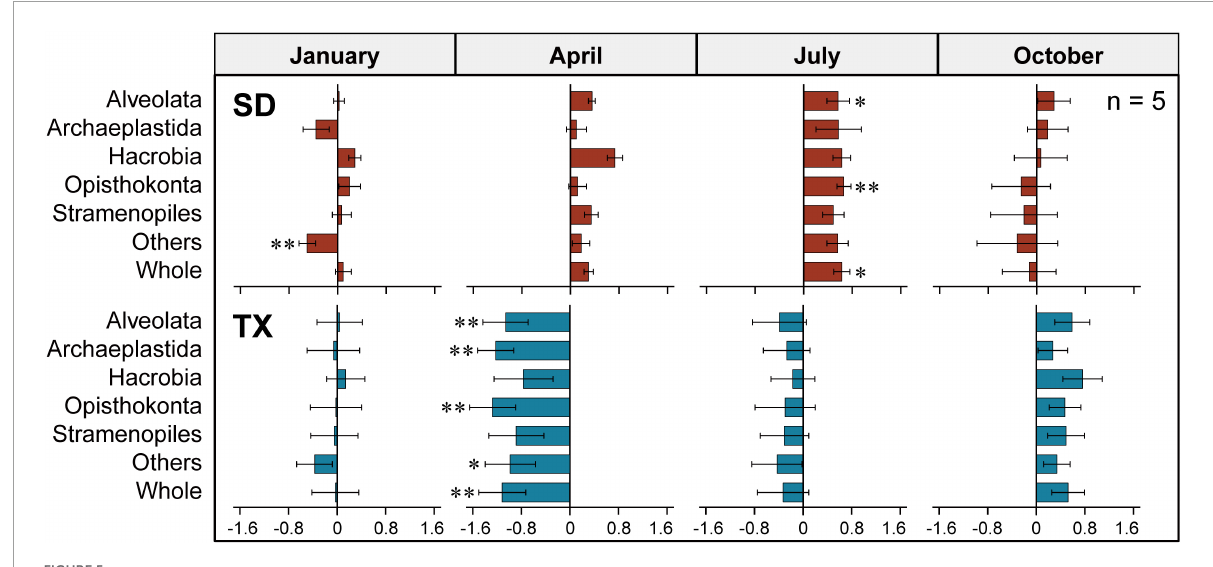
FIGURE5 Differences of the 18S rRNA gene copy abundance between the two size-fractioned plankton communities at the supergroup level in Shidou (SD) and Tingxi (TX) reservoirs across four seasons, respectively. Size fractions: 0.2–200 µ m vs. 0.2–3 and 3–200 µ m. The data were log10-transformed. The error bar represents the standard error ( n = 5). Statistical analysis is non-parametric Mann–Whitney U test ( ∗ P < 0.05, ∗∗ P < 0.01). Others includes Amoebozoa, Apusozoa, Excavata, and